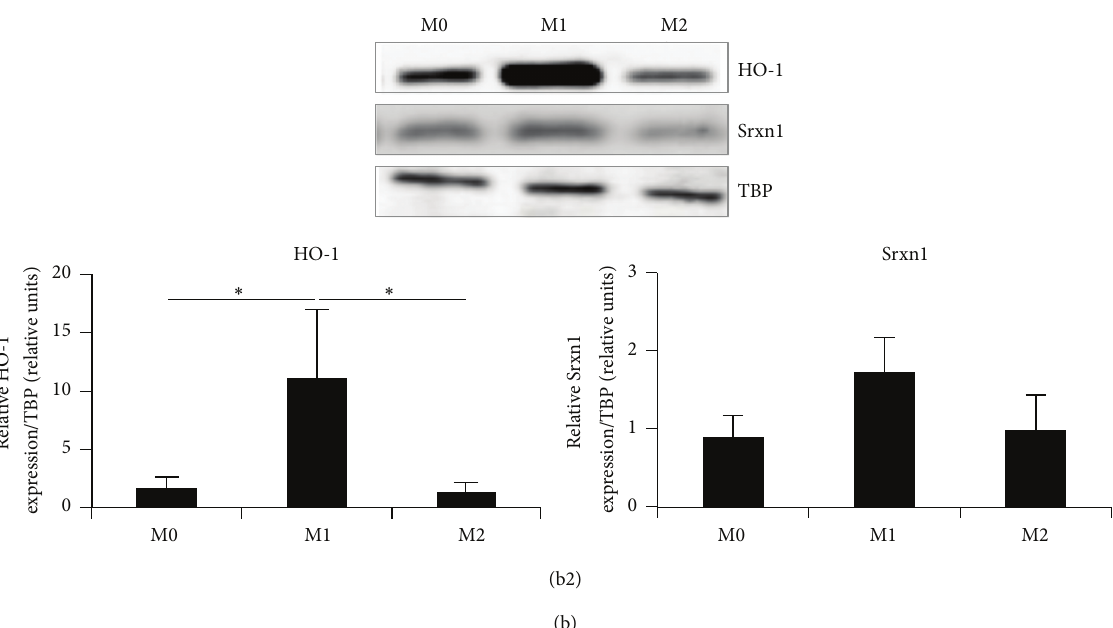
Figure 2: Characterization of M0, M1, and M2 polarized BMDMs. (a) Expression of polarization marker genes at the mRNA level (RT-qPCR) in M0, M1, and M2 macrophages. The expression of marker genes was analyzed as described in Figure 1 and the data were expressed as mean fold induction relatively to M0 cells ± SD ( 𝑛 = 3 ). (b) Expression of polarization markers at the protein level in M0, M1, and M2 macrophages. (b1) Production of secreted IL-6 (M1 marker) in cell culture supernatants assessed by ELISA. Data are expressed relatively per 𝜇 g of protein per well as mean ± SD ( 𝑛 = 3 ). (b2) Expression of HO-1 and Srxn1 assessed by Western blotting in M0, M1, and M2 macrophages. Data are normalized with TBP used as loading control and expressed as mean ± SD ( 𝑛 = 4 ). Results are representative of 4 independent experiments. ANOVA 1: ∗ 𝑝 < 0.05 and ∗∗∗ 𝑝 < 0.001